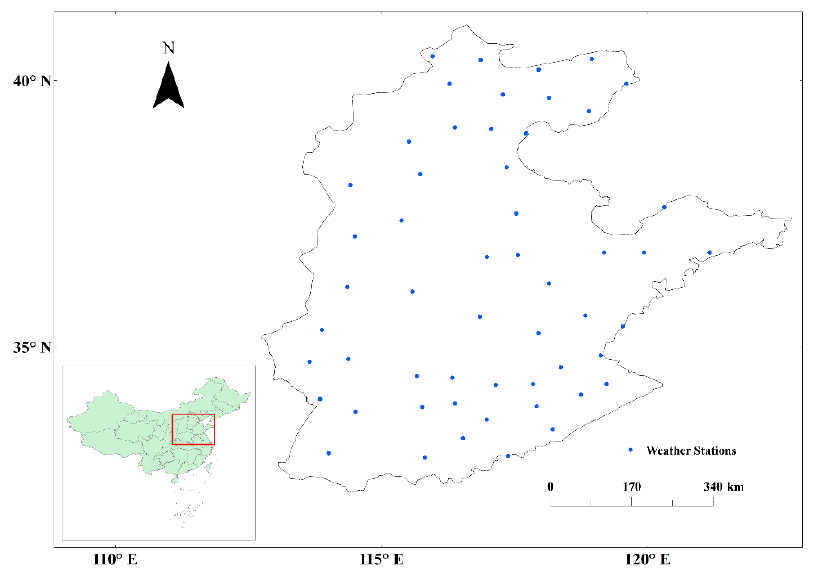
Figure 1. Spatial distribution of meteorological stations in the study area.